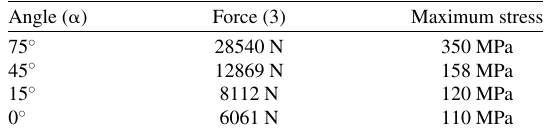
Table 3 Maximum stress reached in the complete test, in four different (cid:2) positions,where (cid:2) istheangleofthehumerusaxiswiththehorizontal plane, and force (3) is the force applied during falling or jumping without muscles failure, see Fig.